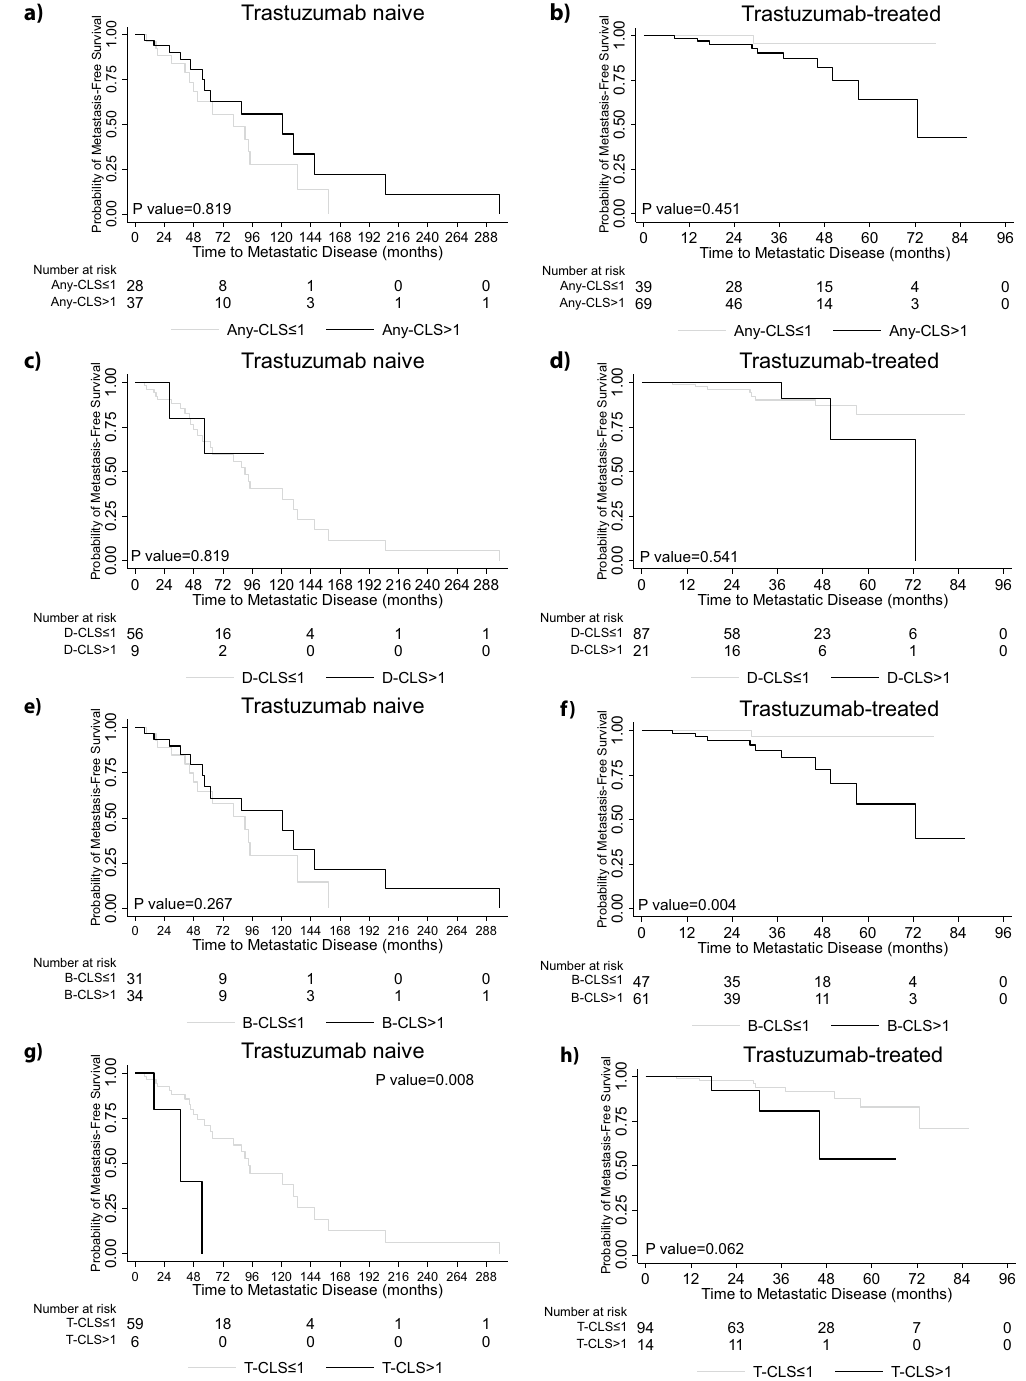
Figure 3. Kaplan–Meier curves showing time to metastatic disease in trastuzumab naïve and trastuzumab- treated patients. ( a,b ) Any-CLS ≤ 1 versus Any-CLS > 1; ( c,d ) D-CLS ≤ 1 versus D-CLS > 1; ( e,f ) B-CLS ≤ 1 versus B-CLS > 1; ( g,h ) T-CLS ≤ 1 versus T-CLS >